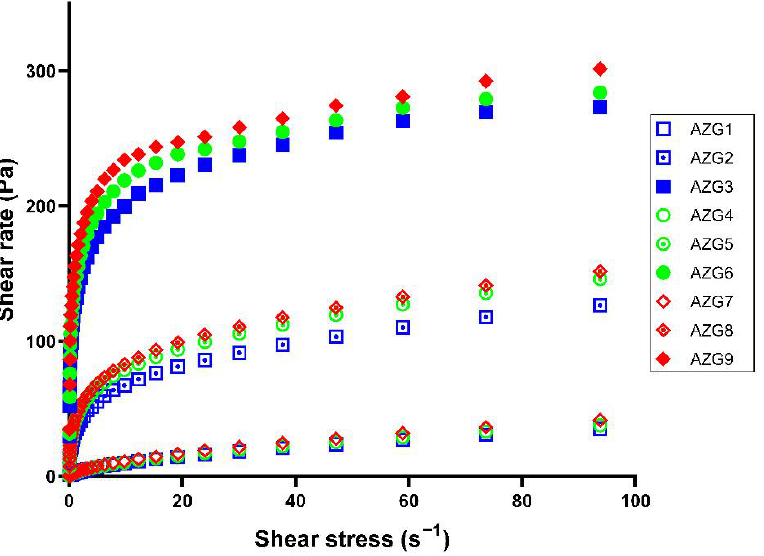
Figure 2. Shear stress and shear rate plots indicating rheological behavior of the solution state of AZG formulations (mean value). AZG formulations (mean